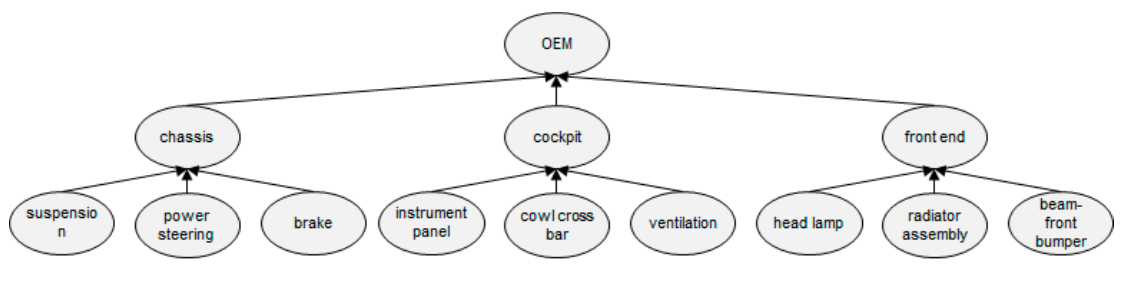
Figure 9. Overall supply chain.